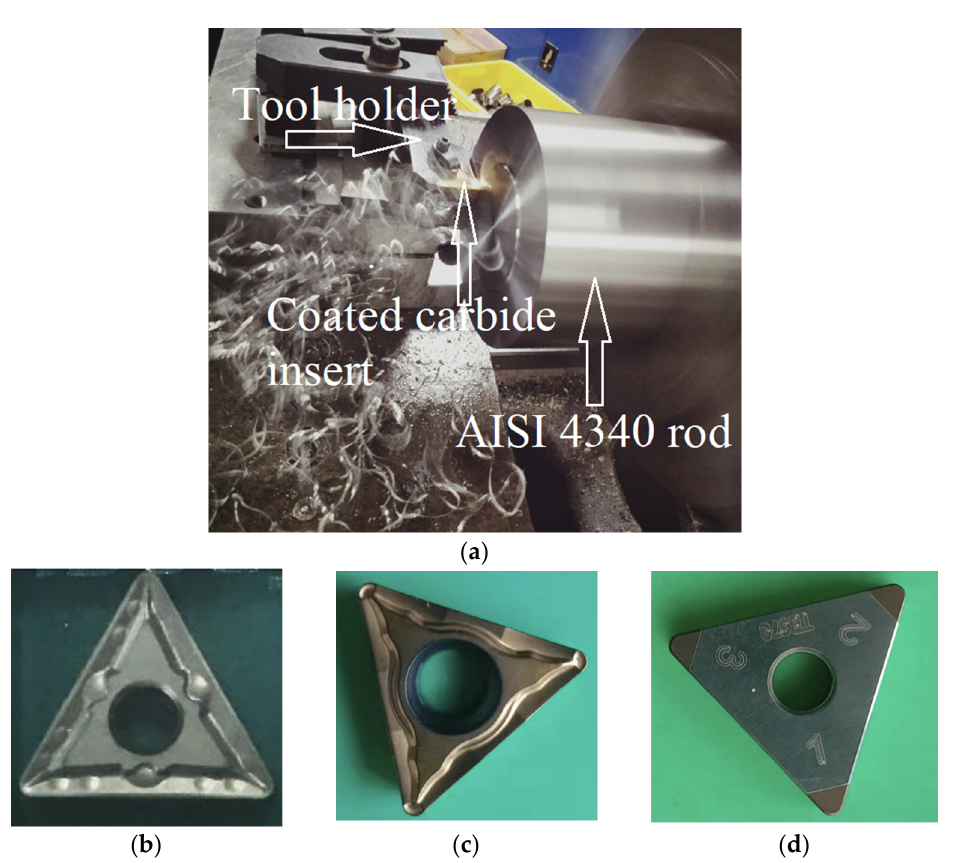
Figure 1. Experimental setup: ( a ) the lathe, tool, and the work material; ( b ) the uncoated carbide insert; ( c ) the coated carbide insert; and ( d ) the cubic boron nitride (CBN) insert.